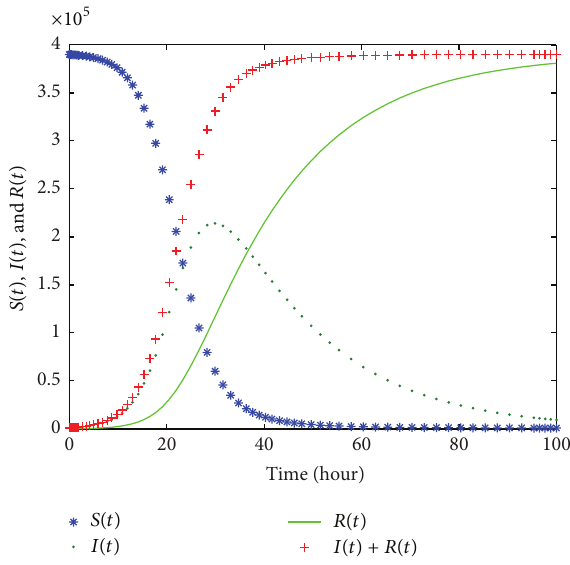
Figure 2: The simulation of KM